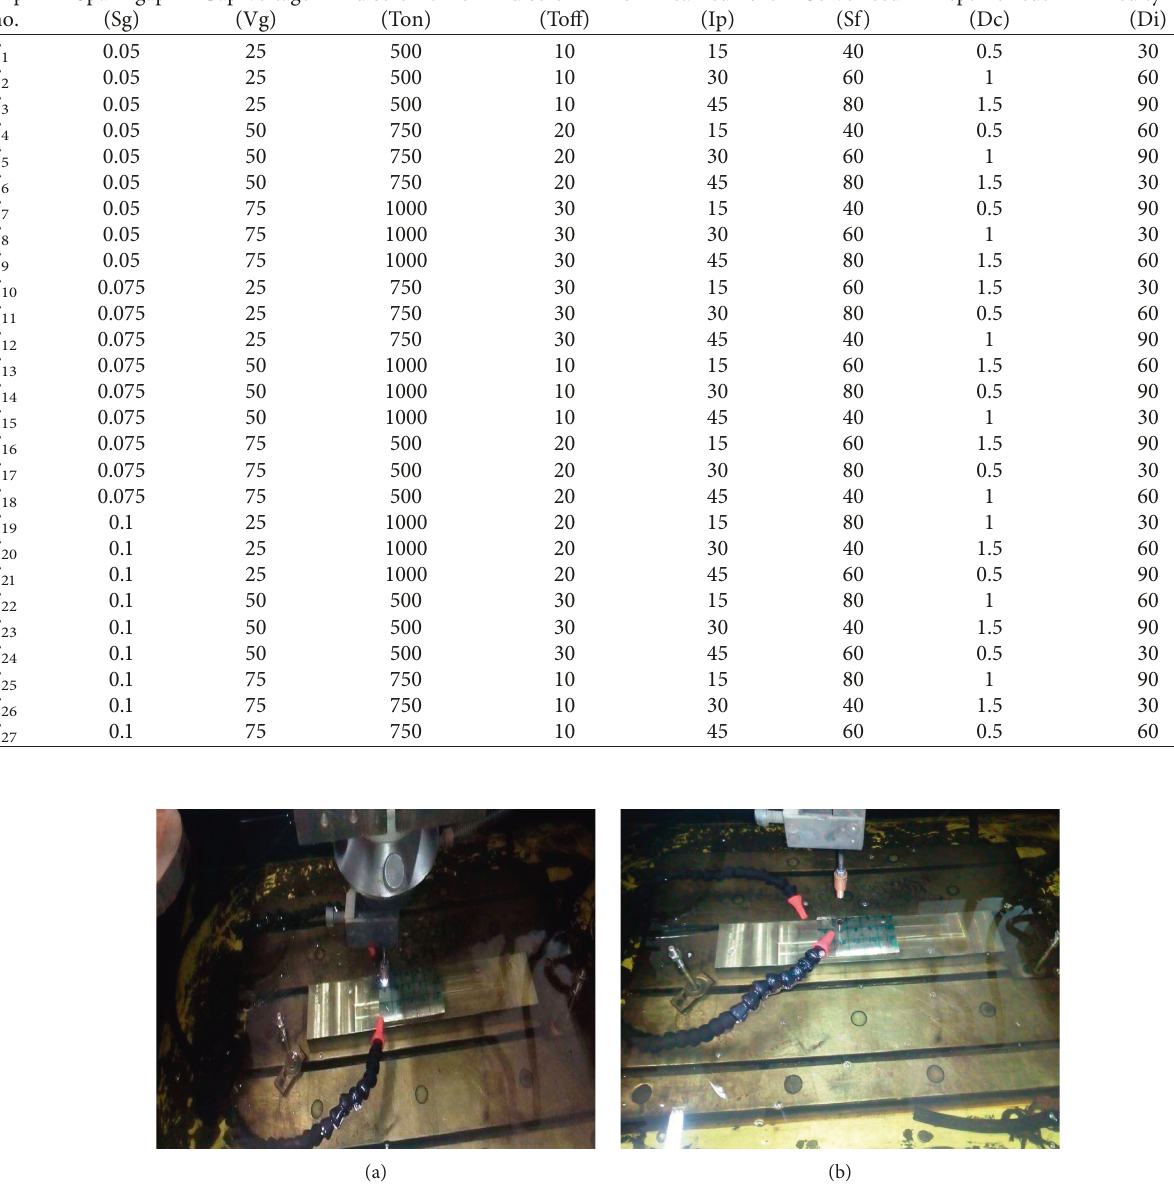
Figure 5: Images showing details of experimentation 1 and experimentation 2. (a) Experiment 1 (run 1). (b) Experiment 2 (run